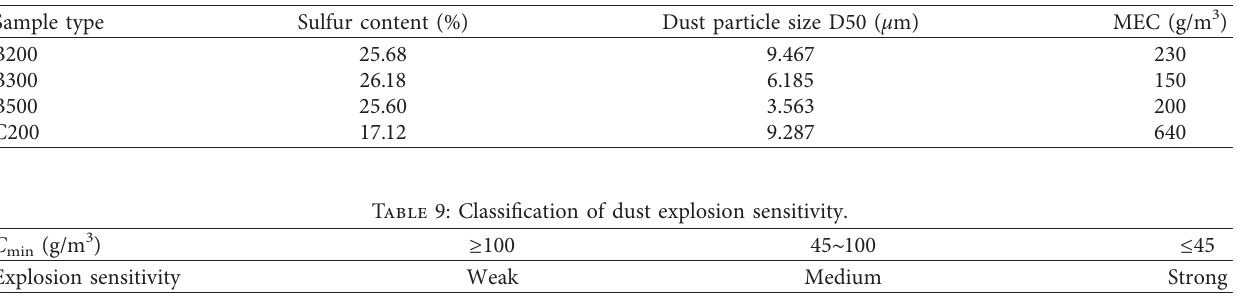
Figure 8: XRD spectra of the explosion product of the metal sulfide ore dust. Table 8: MEC of the metal sulfide ore dust clouds.